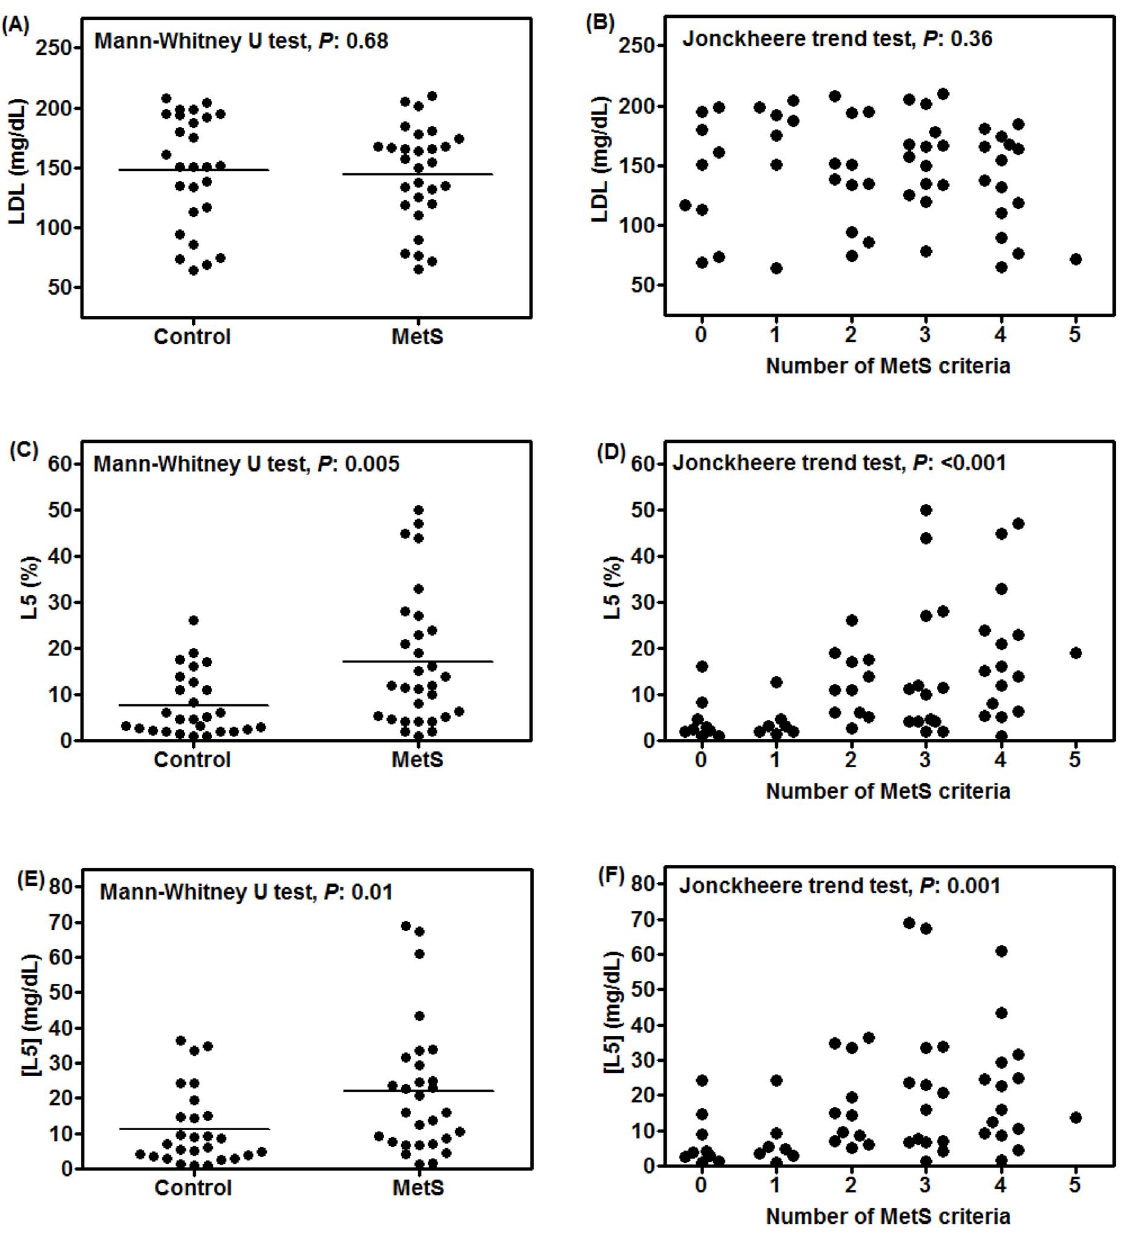
Figure 2. Correlation of low-density lipoprotein (LDL) concentration, L5 percentage (L5%), and L5 concentration ([L5]) with metabolic syndrome (MetS) and the number of MetS criteria. LDL concentration, L5%, and [L5] were plotted for MetS and control subjects and according to MetS criteria. Correlation of LDL concentration with (A) MetS and (B) the number of MetS criteria. Correlation of L5% with (C) MetS and (D) the number of MetS criteria. Correlation of [L5] with (E) MetS and (F) the number of MetS